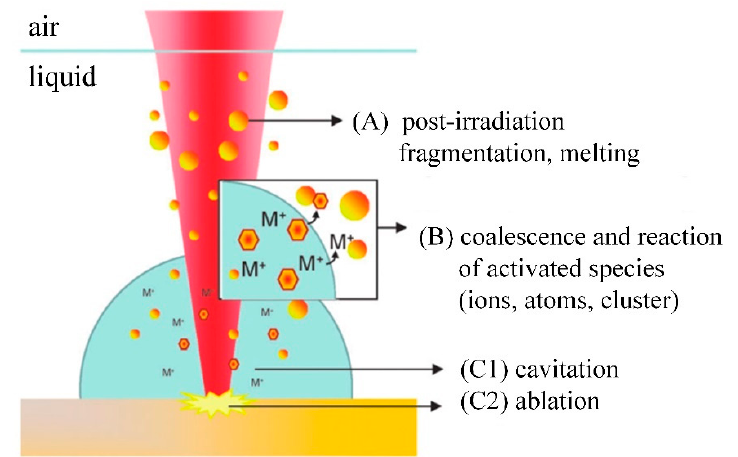
Figure 3. Mechanism of nanoparticle synthesis during the LAL process: (A) interaction of colloidal particles with laser beam; (B) polymerization and reaction of generated NPs with colloidal particles; (C1) generates an expansive cavitation bubble, within which crystallized NP is formed through nucleation and coalescence; (C2) incident laser pulse is adsorbed by the bulk material to form plasma. Reprinted/adapted with permission from Ref. [32]. Copyright 2014, Royal Society of Chemistry.